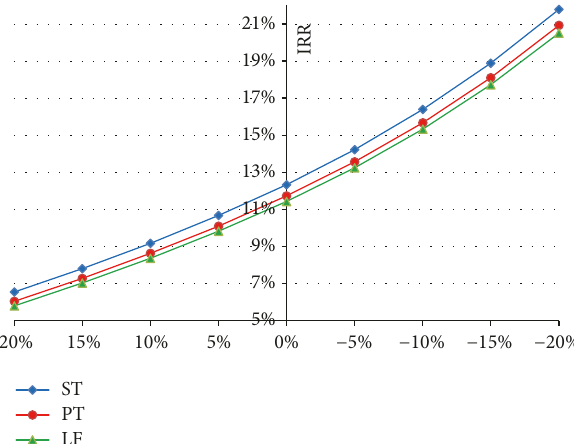
Figure 2: The sensitivity analysis results of the IRR of CSP to the initial costs.